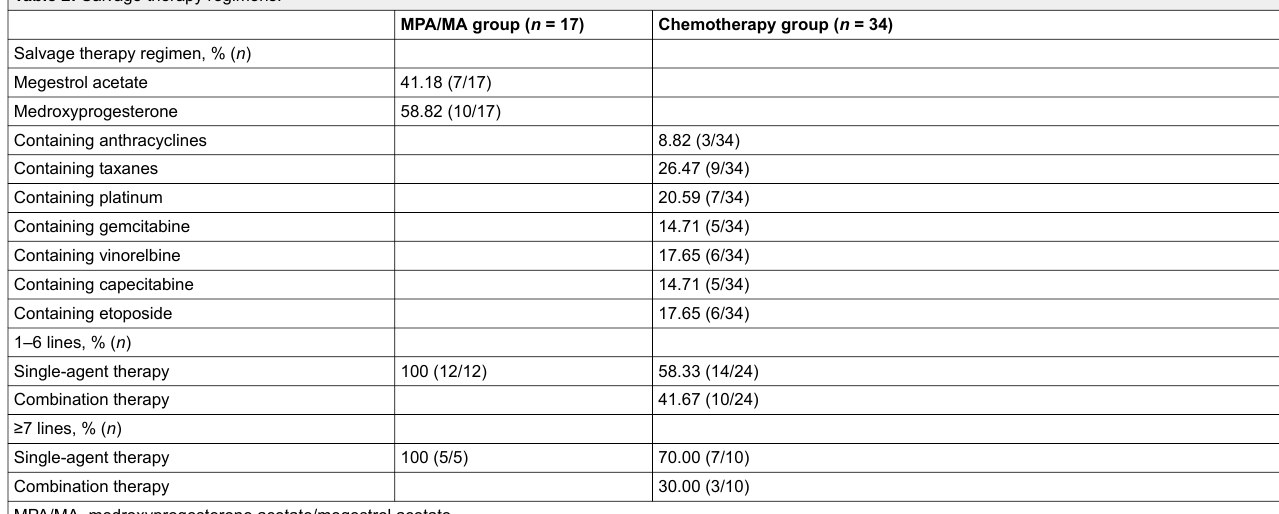
Table 2: Salvage therapy